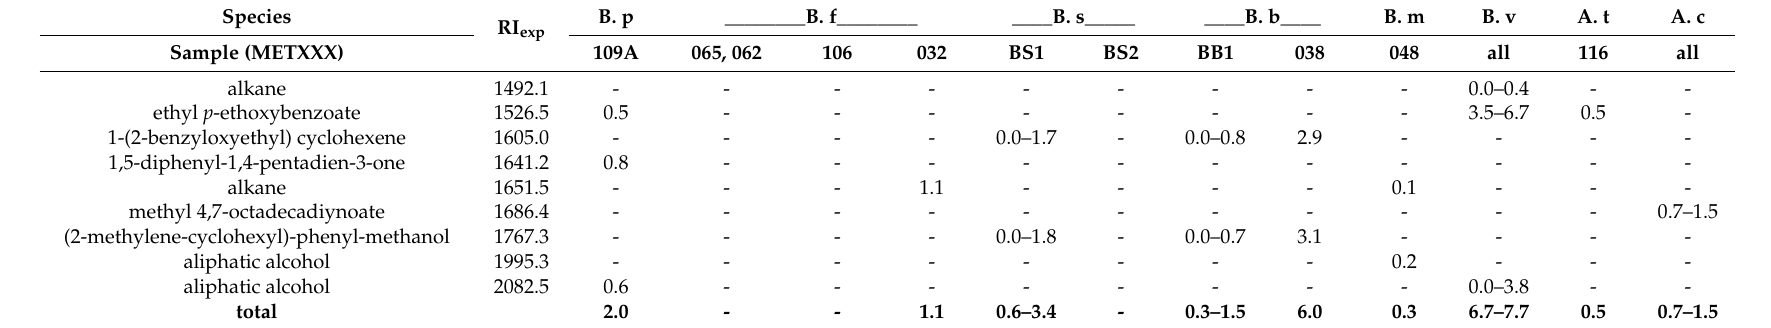
Table 10. Non terpenic constituent composition (relative percentage, %) of the analyzed